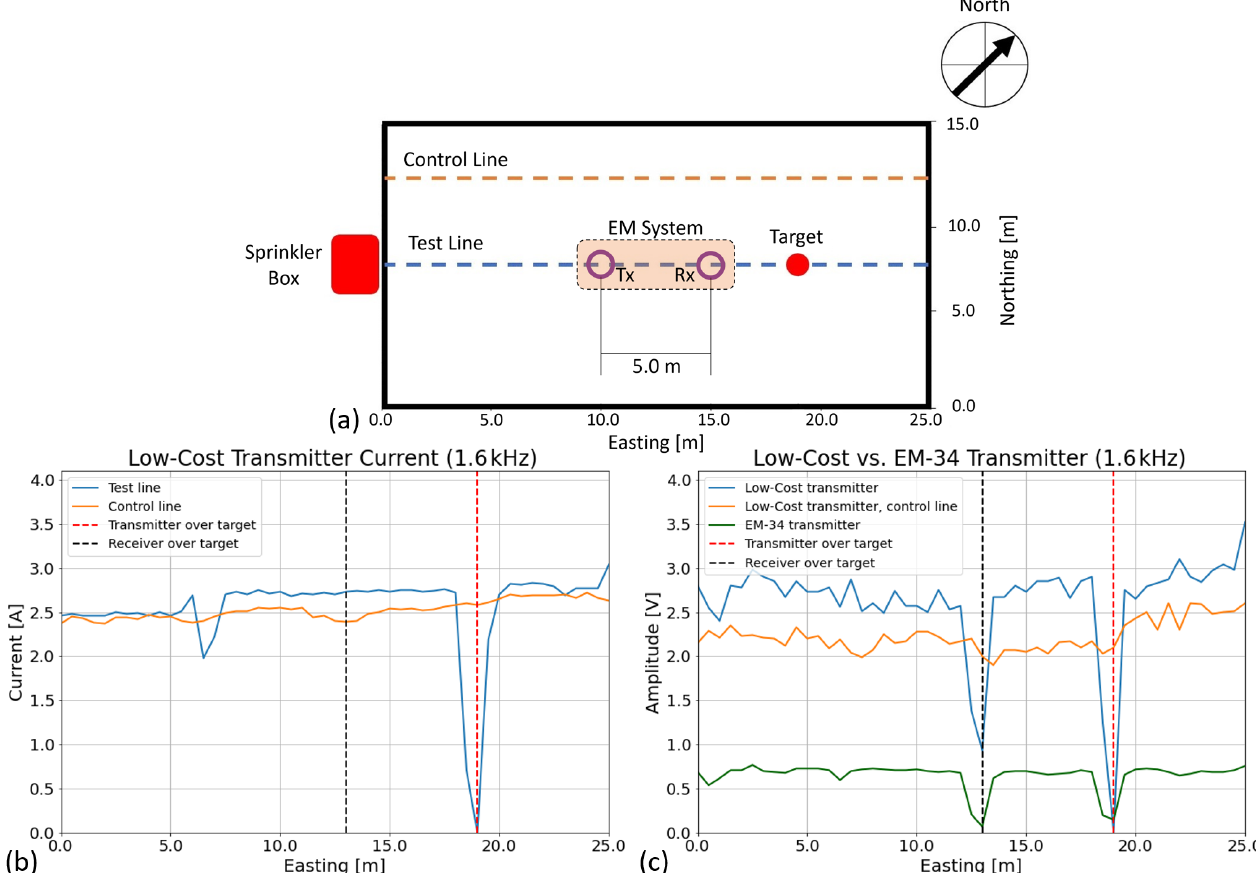
Figure 9. Geometry and results from the CSM-GDL field validation test using a 1.6kHz T x frequency. (a) Survey geometry showing the 0.75m diameter manhole cover surface target located at 18.5m easting on the test line. The control line is parallel to and 4m north of the test line. The only other known nearby conductive body is a sprinkler box located close to the survey area. (b) The blue and orange curves show CSM-EM T x current for the test and control lines, respectively. Along the test line, the T x current dips when the antenna is directly over the manhole cover, as well as at 6.5–7.0m easting. (c) The green and blue curves show the test line voltage data for the EM-34 T x and CSM-EM R x and the CSM-EM T x − R x combinations, respectively. Both curves show significant RMS voltage reductions when either the - T x or R x passes over the target. The orange curve presents the control line data unaffected by the surface metal